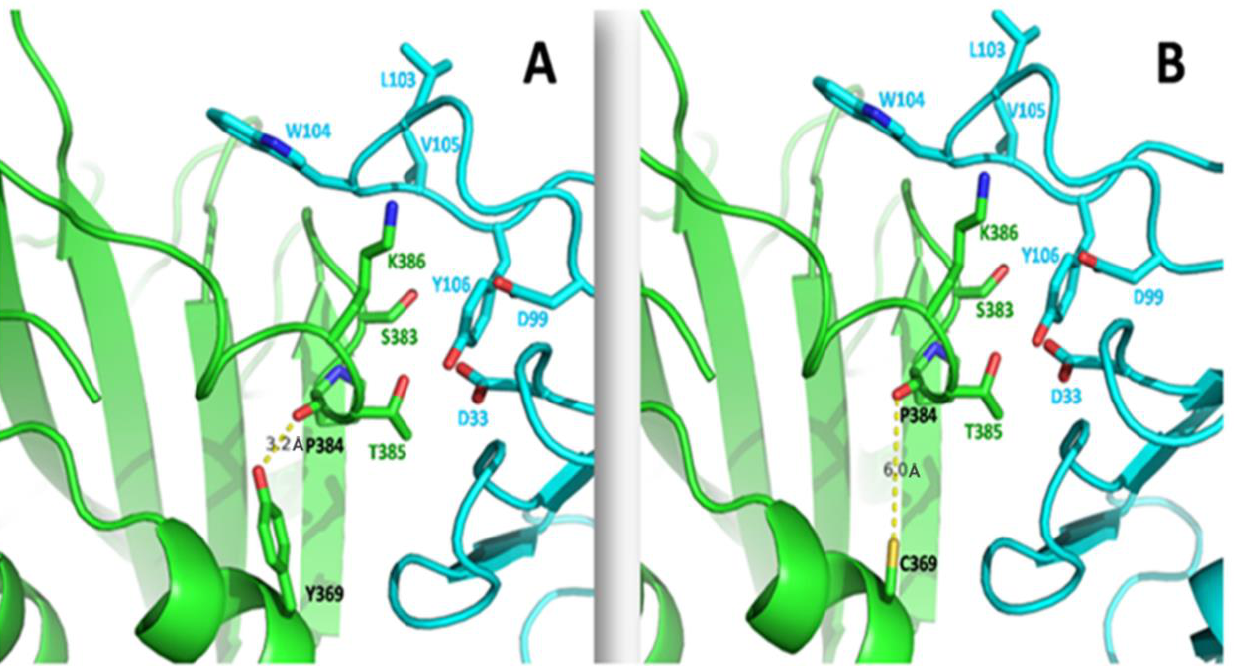
Figure 12. The interactions among the EY6A antibody with spike RBD region were taken from PDB: 6ZDG. The structure in green represents the RBD region of spike glycoprotein. The structure in cyan represents the EY6A Fab. ( A ) The interaction between Y369 and P384 is indicated, with a bond distance of 3.2 Å; ( B ) The interaction of mutated Y369C with P384 is shown, where the interaction distance increases to 6.0 Å which subsequently increases the flexibility of the binding region of spike glycoprotein. The yellow dotted line represents the hydrogen bond interaction. The length between residues is shown in units of Angstrom (Å).